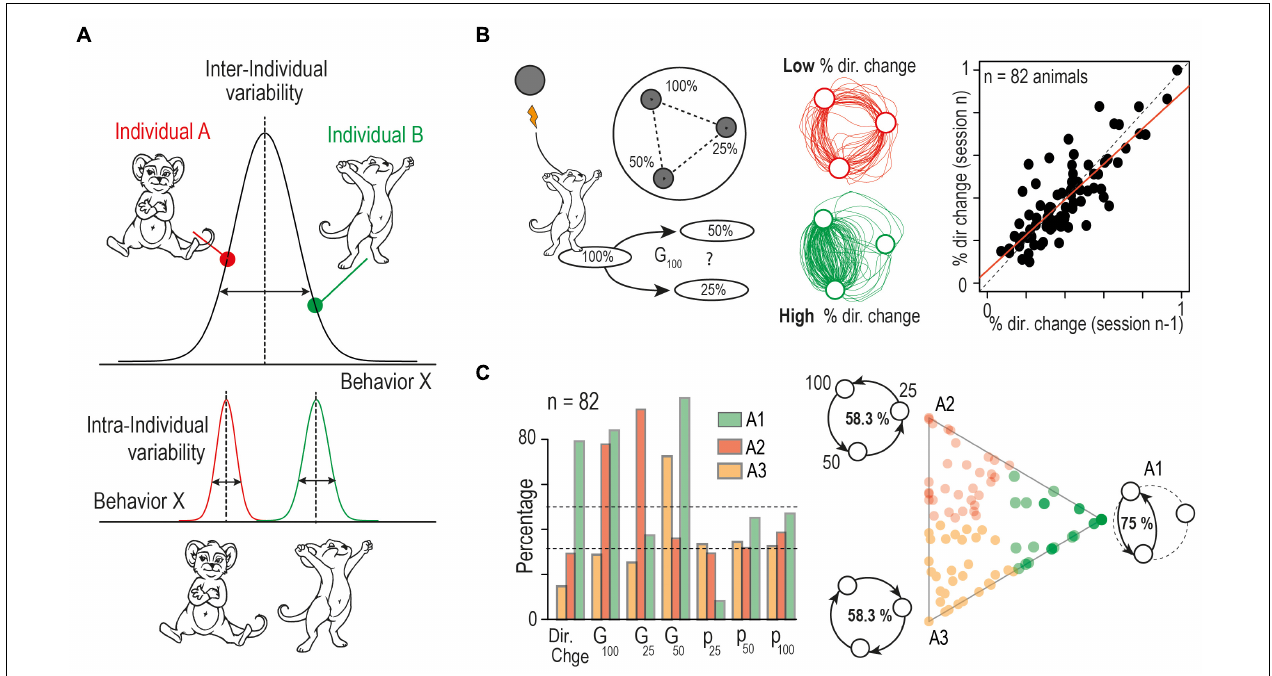
FIGURE 1 | Theoretical framing and experimental distinction between inter- and intra- individual variability. (A) Defining intra and inter-individual variability: the frequency and intensity with which an individual exhibits a specific behavior defines a trait. The estimate of the trait expression at the population level defines inter-individual variations. Repeated measurements on individual subjects allows the estimation of intra-individual variations in trait expression. (B) ( Left ) Schematic of a behavioral decision-making paradigm where inter- and intra-individual variability is apparent. Mice are placed in a circular open-field with three equidistant targets that are associated with a given probability (100, 50 or 25%) of intracranial stimulation reward delivery when the animal is detected around the target. The animal cannot receive two consecutive stimulations from the same target; thus they must make a sequence of binary choices between the targets. The trajectories and choice or each mouse are quantified using, (i) the percentage of directional change (i.e., returning to the previous target, % dir. change), (ii) the probability to visit each point (P 100 , P 50 , P 25 ) and (iii) the probability to choose the option with the highest probability of reward for the three possible “gambles”: G 100 = choice of 50% over 25%, G 25 = choice of 100% over 50 and G 50 = choice of 100% over 25%. ( Center ) Example of two trajectories obtained from two different mice across a 5 min session showing individualistic strategies where the mouse in the top trace shows a low propensity for changing direction, resulting in a more circular trajectory, while the mouse in the bottom trace shows a high percentage of directional change, focusing on the most rewarded options. ( Right ) Analysis over concurrent sessions indicates consistent differences in behaviors between mice indicative of low intra-individual variability and high inter-individual variability. Correlation between the percentage of directional changes for two consecutive sessions shows a strong stability between strategy across sessions within individual mice, while behavior between subjects remains variable. (C) Archetypal analysis: ( left ) Plot of the three archetypal solutions, and their seven basic variables (see B ). Left : Visualization of the α coefficients using a ternary plot. Each point represents the projection of an individual onto the plane defined by a triangle where the three apices represent the three archetypes (A1, A2, A3). Points are color-coded according to their proximity to the archetypes. Schematic at the three apices illustrate the main behavior of the three archetypes. A1 corresponds to a mouse that alternates only between p 100 and p 50 . Such a mouse would reach a 75% success rate. In contrast, mice using a purely circular strategy would have a 58.3% success rate. They either turn in a descending manner (A2: sequence p 100 – p 50 – p 25 ) or an ascending manner (A3: sequence p 25 – p 50 – p 100 ). Experimental mice fall somewhere within the boundaries of these extreme behaviors. (Modified from Dongelmans et al.,